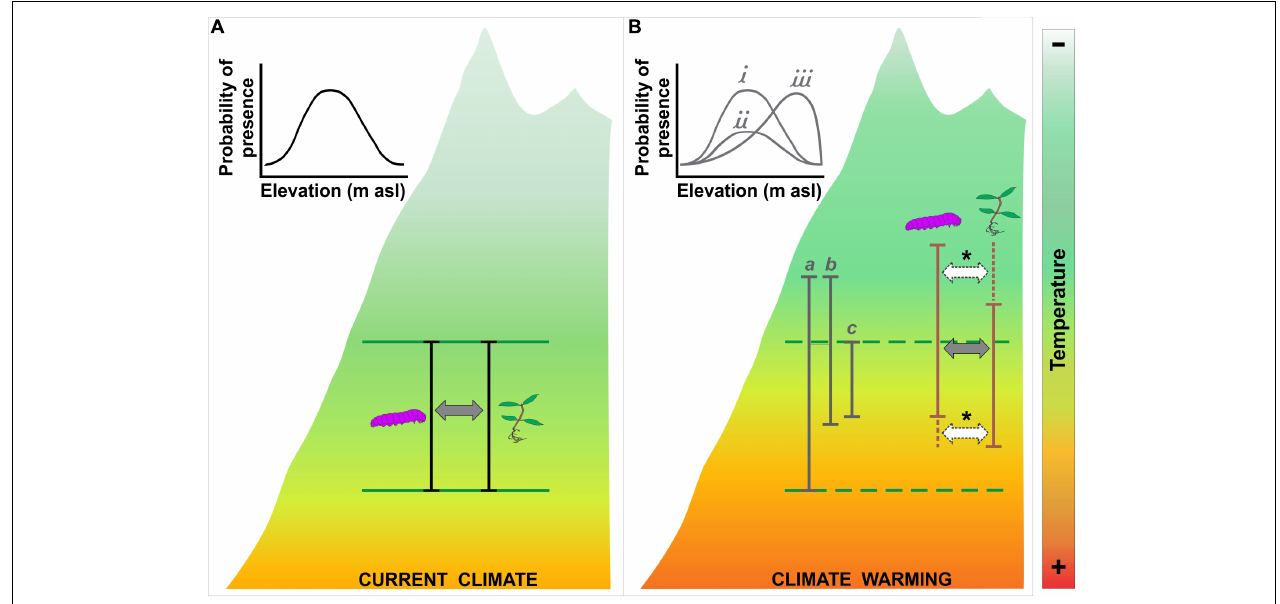
FIGURE 2 | Schematic representation of possible scenarios of species distribution changes in response to warming. The mountain is represented by the background figure and the color gradients represent the altitudinal variation in temperature. (A) Current conditions showing the range of distribution of a species (black bar and delimited by green lines) and the hypothetical probability of occurrence. (B) Possible changes in distribution and abundance patterns under climate change scenarios. Some hypotheses are: warming can lead to range expansion ( a ), shifts ( b ) or contractions ( c ), and probability of occurrence will likely remain stable ( i ), decrease over the range ( ii ) or move to the range margin ( iii ) (Feeley et al., 2012; Feeley, 2015; Peterson et al., 2019). On the right side, potential plant-animal (e.g., herbivores, pollinators, predators; represent by caterpillar) interaction partners mismatches (*) under asynchronous species migration scenarios are